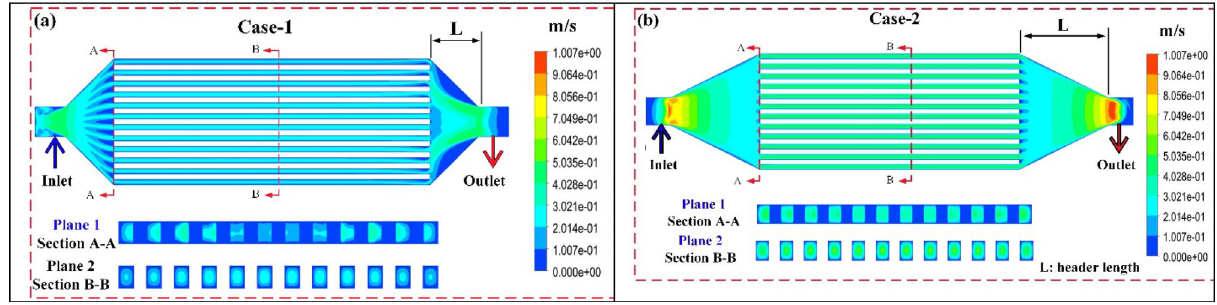
Figure 7. DL-MCHS header optimization.